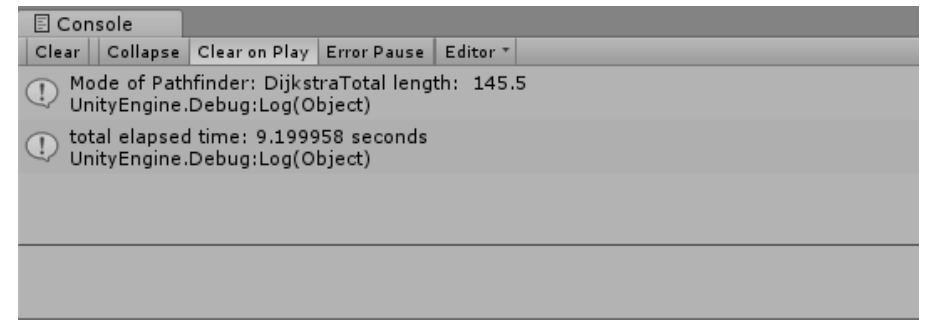
Figure 19. The shortest route length and the travel time.